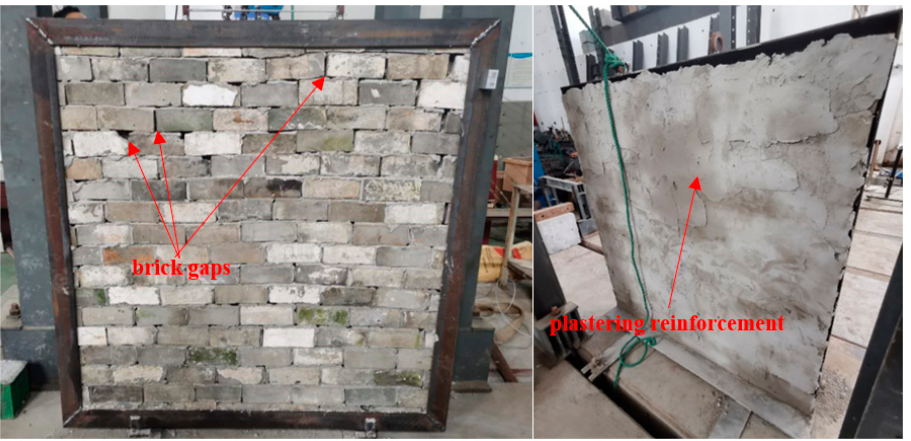
Figure 7. Wall specimen and plastering reinforcement.